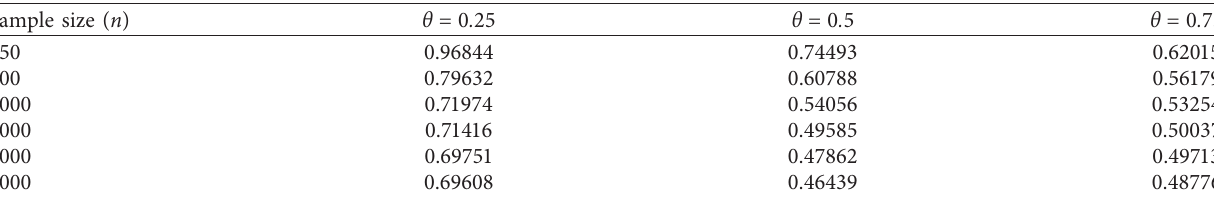
Table 2: ARMSE for 􏽢 μ